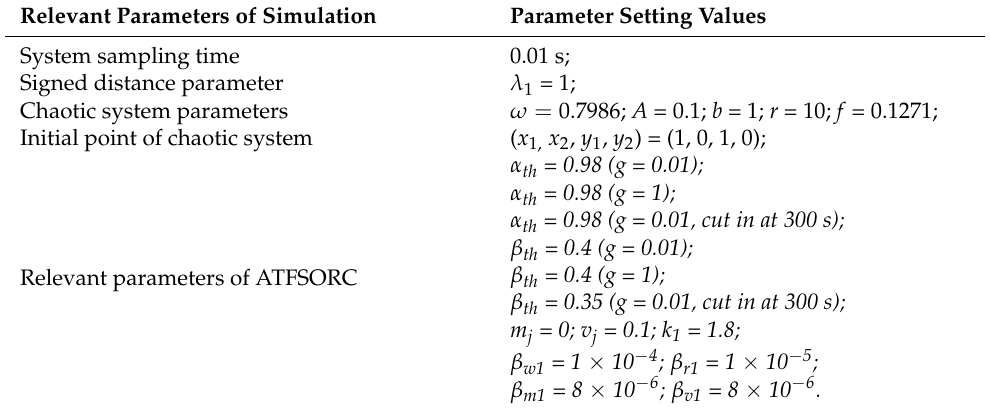
Table 2. Simulation parameters for the synchronization control of chaotic systems. Relevant Parameters of